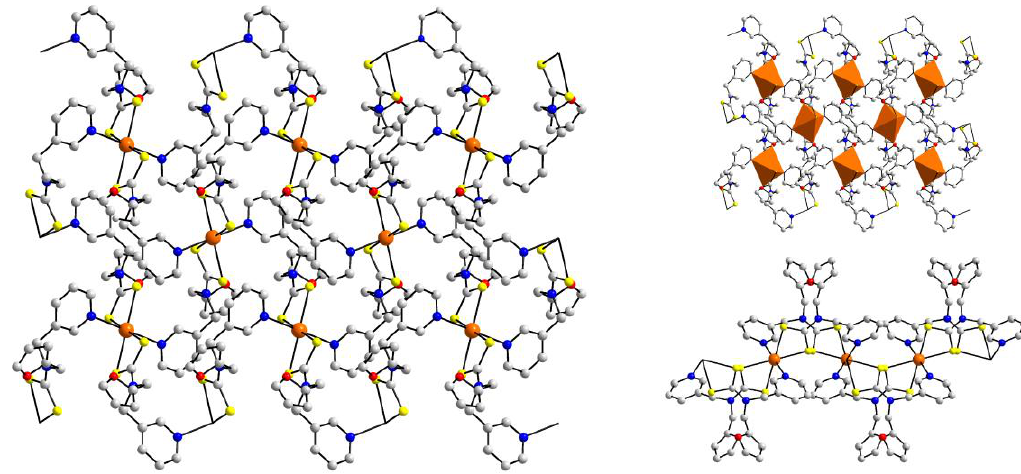
Figure 11. Plan and side-on views of the two-dimensional array in the crystals of [Cd(L 2 ) 2 ] n ( 35 ); one plan view highlights the arrangement of the coordination polyhedra.